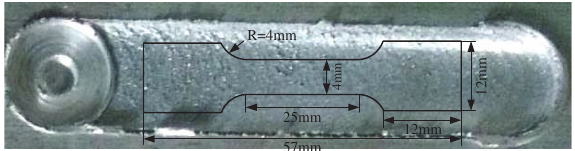
Figure 3: Dimensions of the FSP